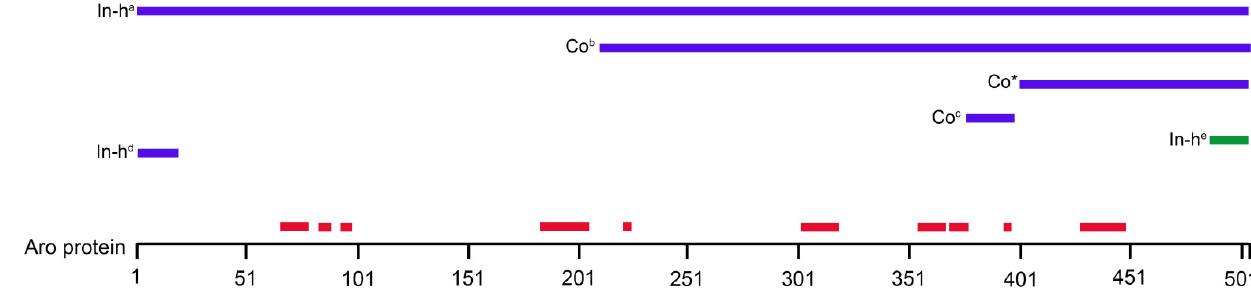
Figure 10. The simplified structure of human aromatase (Aro) protein with important conserved regions shown in red (based on Di Nardo et al. [8]). Blue lines indicate which parts of the human Aro protein were used to produce antibodies for Aro detection in CNS studies (Table 1). Green line indicates a mouse Aro peptide to generate an anti-mouse Aro antibody. Co: commercially available antibodies; In-h: anti- bodies made and validated in-house; * the Novus Aro antibody used in this study.